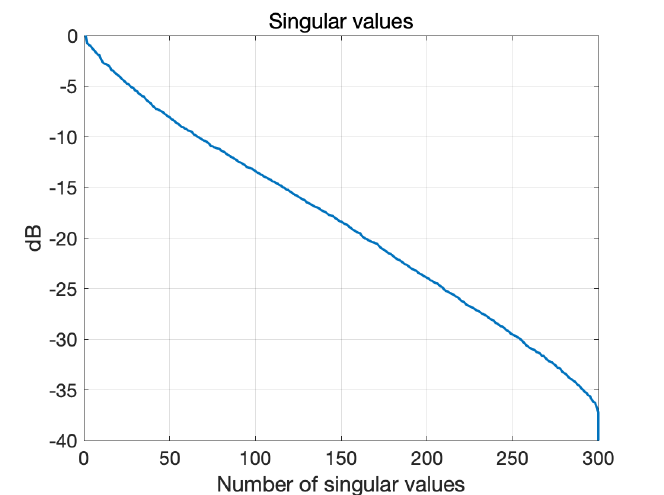
Figure 8. Singular value behavior of the scattering